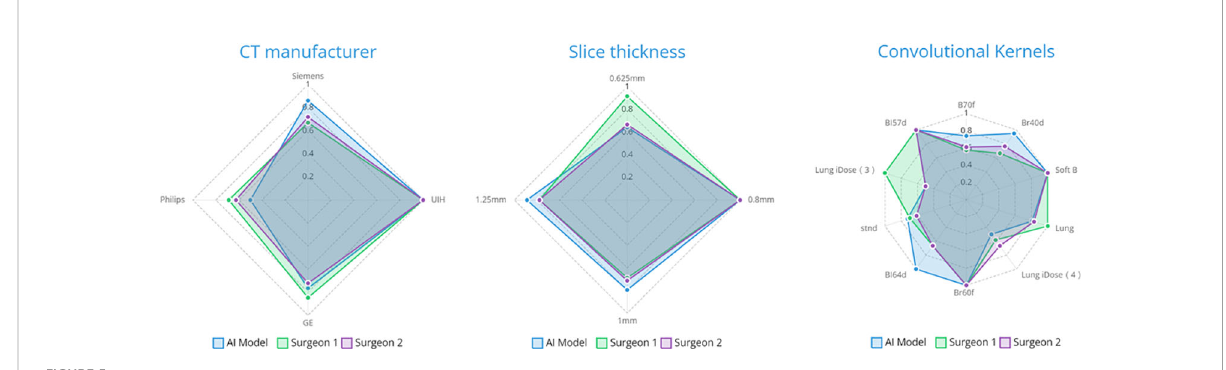
FIGURE 5 The impact of radiological parameters on accuracy on three parties.